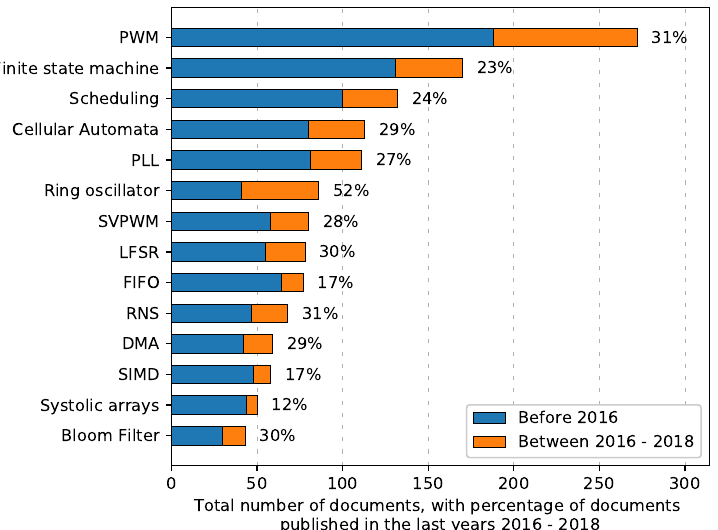
Figure 16. Other top implementations techniques in FPGA